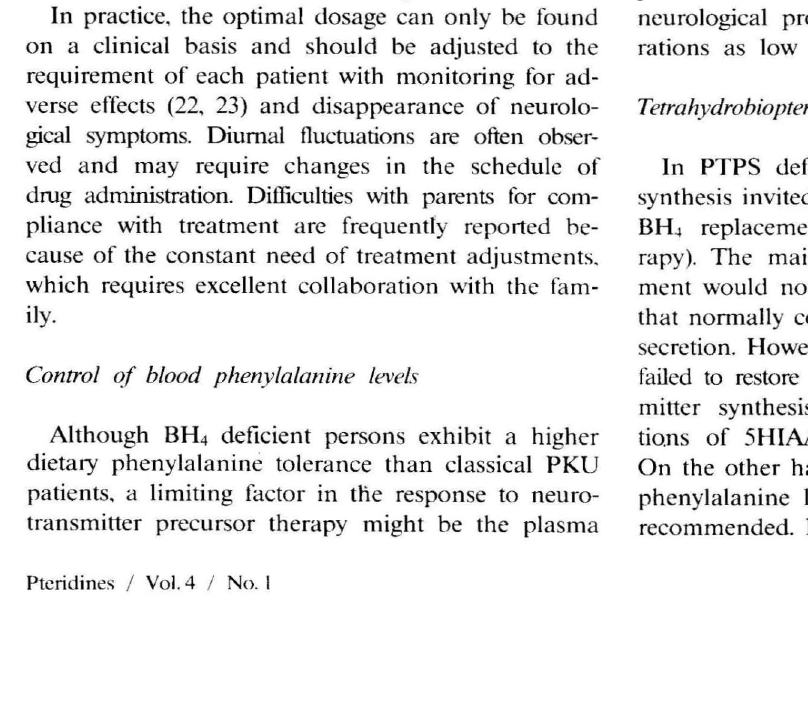
Figure 4. CSF levels of 5HIAA and HVA of patients with DHPR deficiency (upper) and PTPS deficiency (lower) . • without treatmen·t; 0 on neurotransmitter precursors; 6 on HH. "monotherapy"; shaded area represents normal range (percentile 5-95) estahlished from the distribution of 292 CSF determinations in normal con/wis.